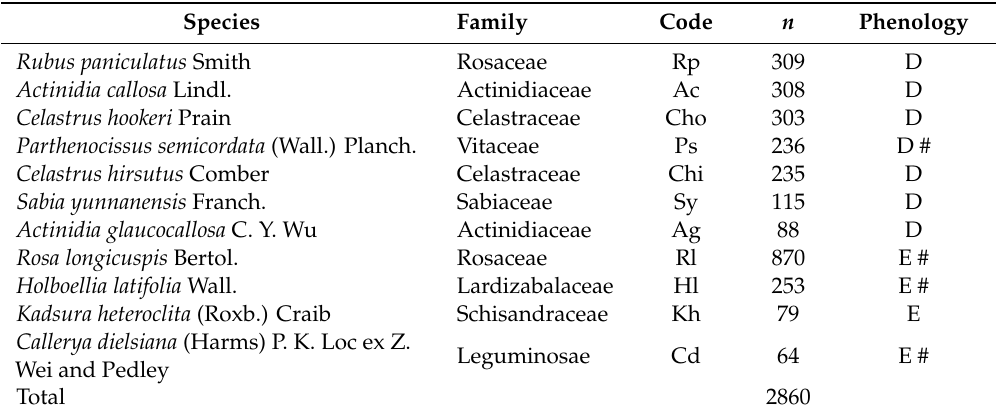
Table 2. Liana species with details of family and leaf habits in a 20 ha forest dynamics plot, SW China.